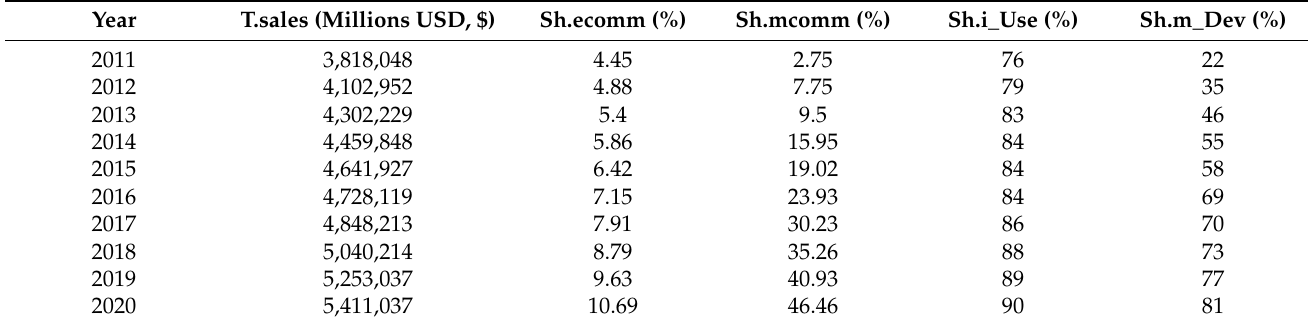
Table 1. Data collected for the research